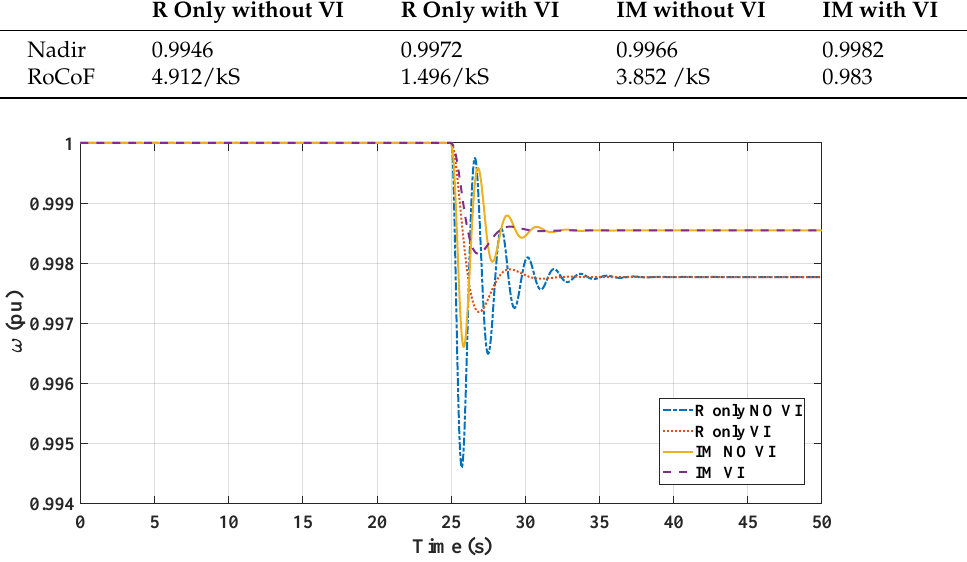
Figure 13. Frequency response at different loading conditions.